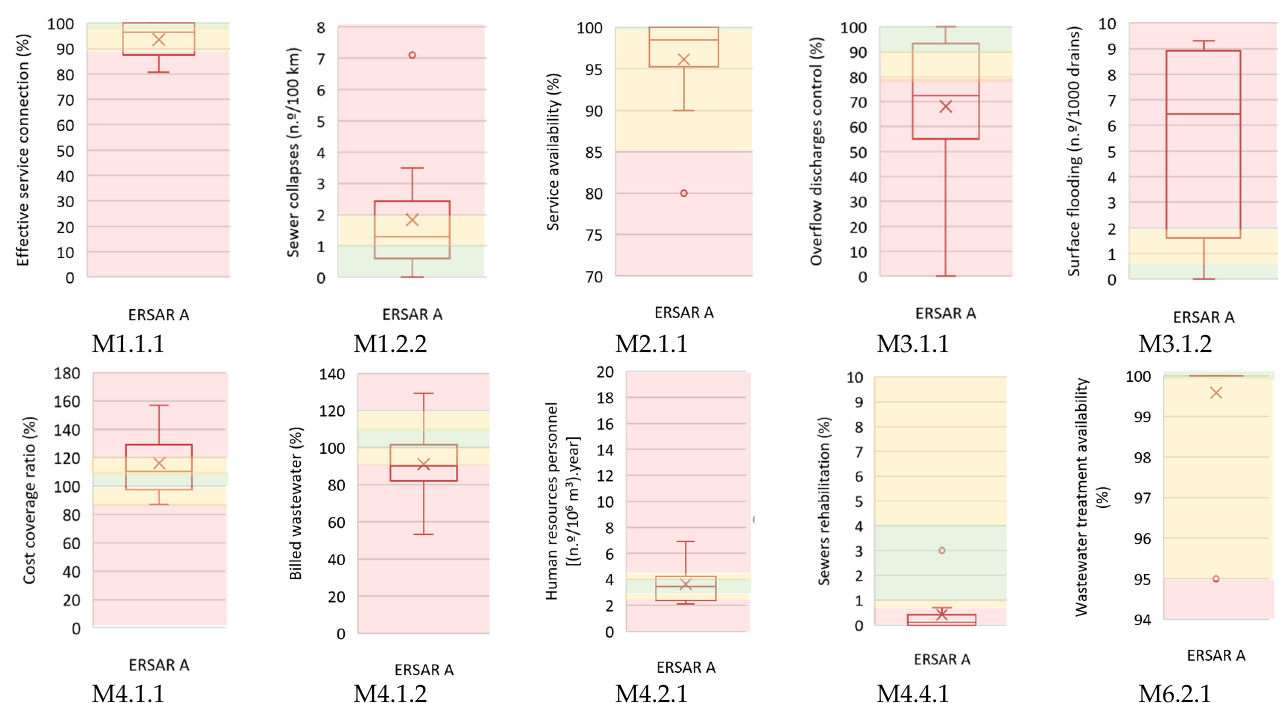
Figure 3. Results of testing applied to data available from ERSAR report for 2018 (12 type A utilities).